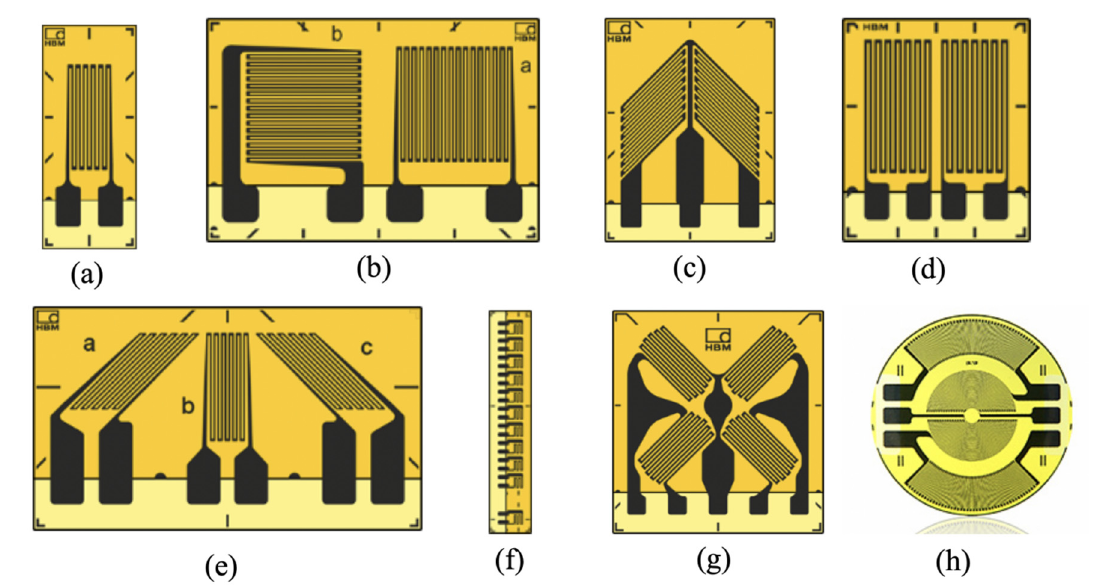
Figure 3. Geometrical structures of various sensitive grids used in resistance strain gauges for different applications. ( a ) Straight strain gauge, ( b ) T strain gauge, ( c ) V strain gauge, ( d ) double-bridge strain gauge, ( e ) triple-grid strain gauge, ( f ) chain strain gauge, ( g ) full-bridge strain gauge, and ( h ) circular-membrane strain gauge.